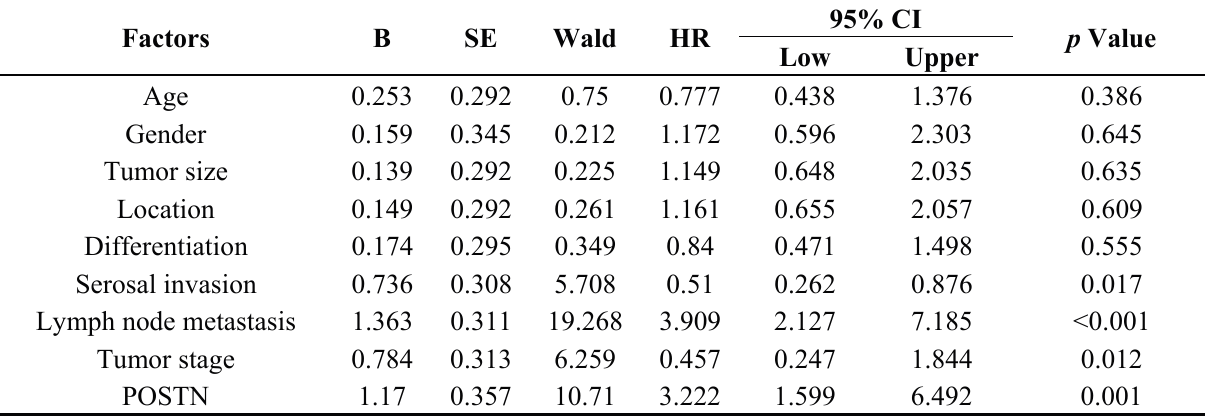
Table 2. Univariate survival analyses of various factors in patients with colorectal cancer. Factors